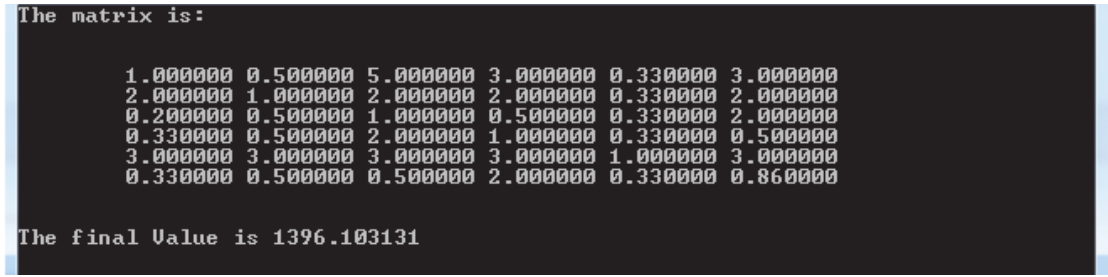
Fig. 2. Permanent function value for alternative 1